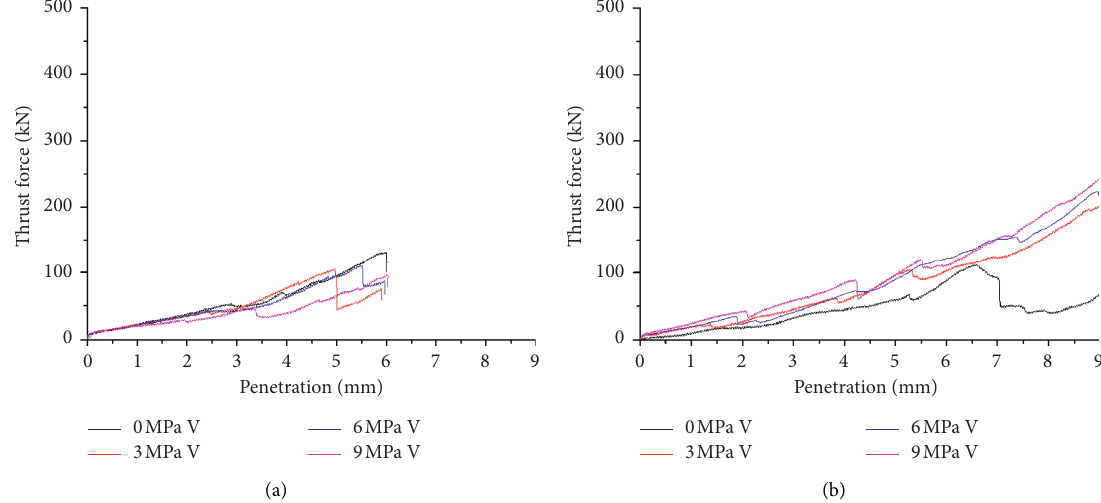
Figure 10: Thrust cutting force evolution patterns under the V shape disc cutter. (a) Ultimate penetration � 6mm; (b) ultimate penetration � 9mm.